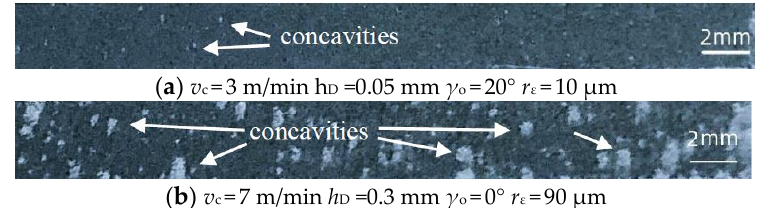
Figure 8. Machined surface at different machining parameters.